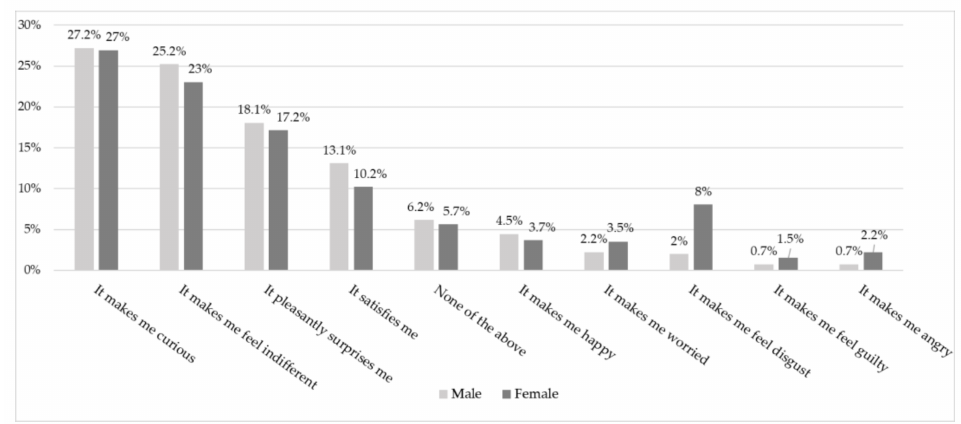
Figure 4. Frequency of emotional terms reported by gender. Pearson’s chi-squared (df) = 16,919 (9), p = 0.012.